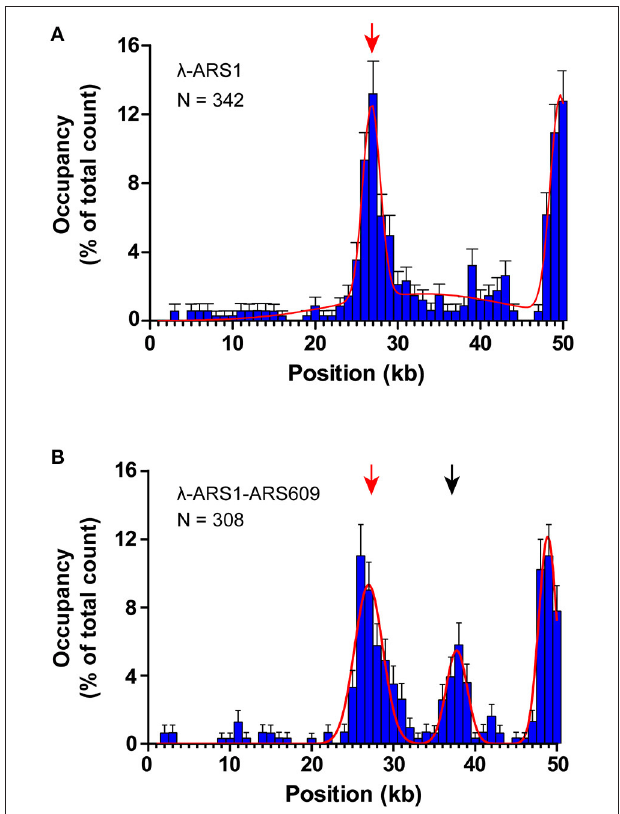
FIGURE 5 | Distributions of ORC binding positions on λ -ARS1 and λ -ARS1-609. (A) Histogram and Gaussian fitting of ORC binding distributions on λ -ARS1. The position of the ARS1 inserted site is indicated by a red arrow. Data were analyzed using R and GraphPad Prism, and an error was defined based on 1000 bootstrap samples and a 95% confidential interval. N stands for the number of ORC molecules. (B) Histogram and Gaussian fitting of ORC binding distribution on λ -ARS1-ARS609. The positions of ARS1 and ARS609 inserted sites are indicated by red and black arrows,